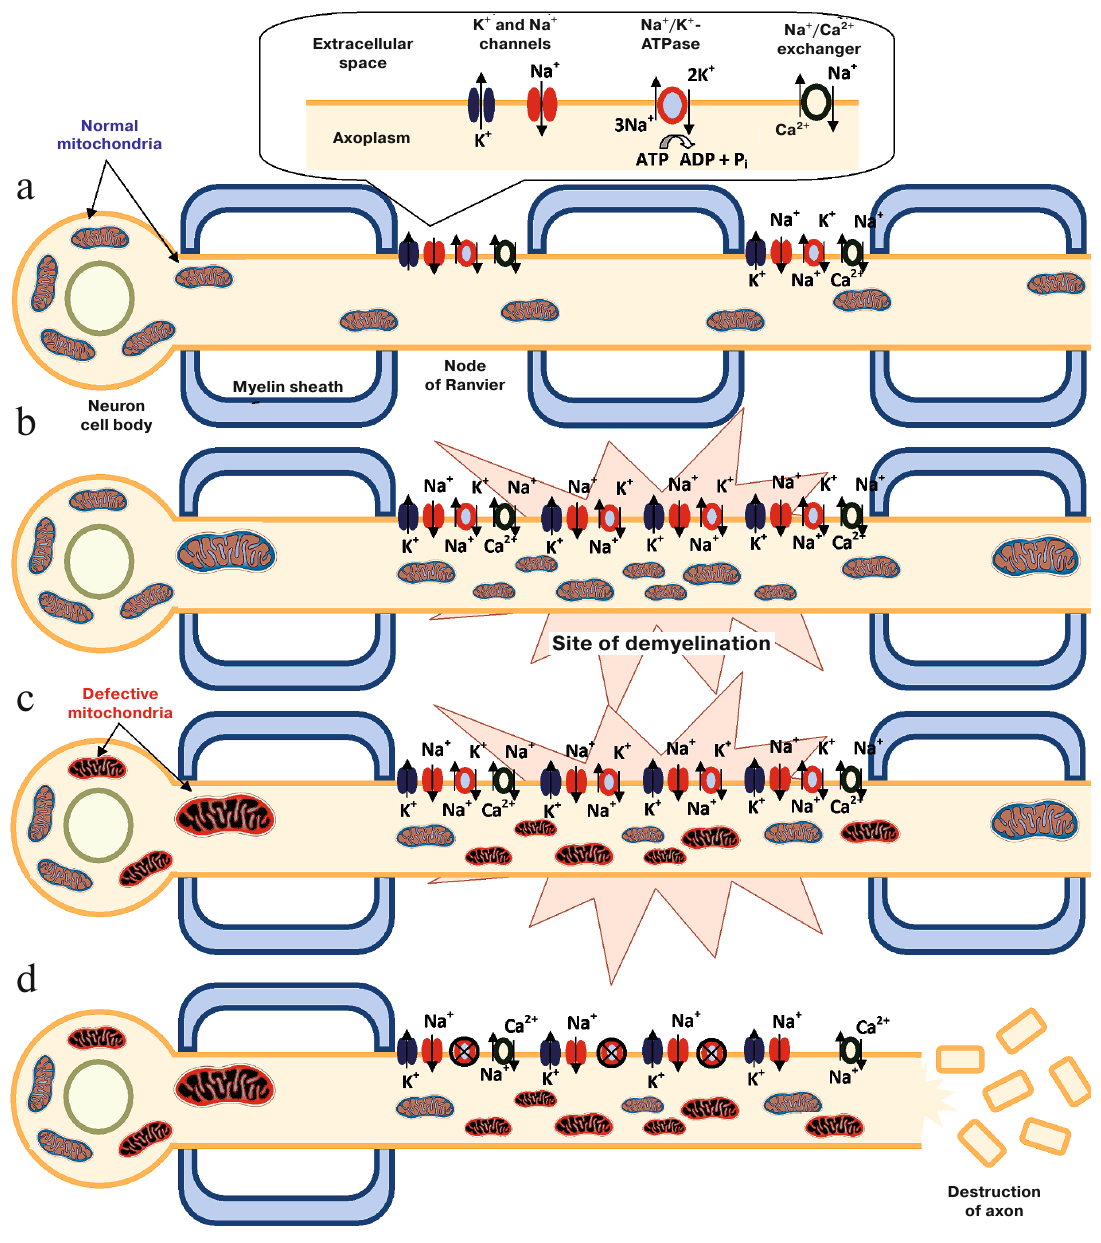
Figure 2. The role of mitochondria in the process of neurodegeneration. a . Normal nerve. b . Site of Fig. 3. Role of mitochondrial dysfunction in neurodegeneration during chronic demyelination. a) Functioning of the nerve fiber under nor(cid:2) demyelination with secondary modification of the distribution of ion channels in the nerve. c. Structural mal conditions; b) redistribution of ion channels in sites of demyelination; c) appearance of defective mitochondria in the region of chronic demyelination; d) disturbance in ion homeostasis inducing Ca 2+ (cid:2)mediated axonal degeneration. See text for detailed description. The figure and functional modification in mitochondria caused by oxidative stress. d . Cascade of apoptosis was created based on data from articles [86(cid:2)89]. activated by Ca 2 + . Figure reprinted with permission from the article “Involvement of Mitochondria in Neurodegeneration in Multiple Sclerosis”, Kozin et al., Biochemistry (Moscow), 2018, Vol. 83, No. 7, sumption of ATP necessary for the work of the Na + /K + (cid:2) and morphology of mitochondrial neurons as a compen(cid:2) pp. 813–830 satory reaction (Fig. 3c). At the same time, with chronic neuroinflammation in the brain tissue the amounts of ROS and nitrogen(cid:2)containing metabolites (e.g. NO) pro(cid:2)